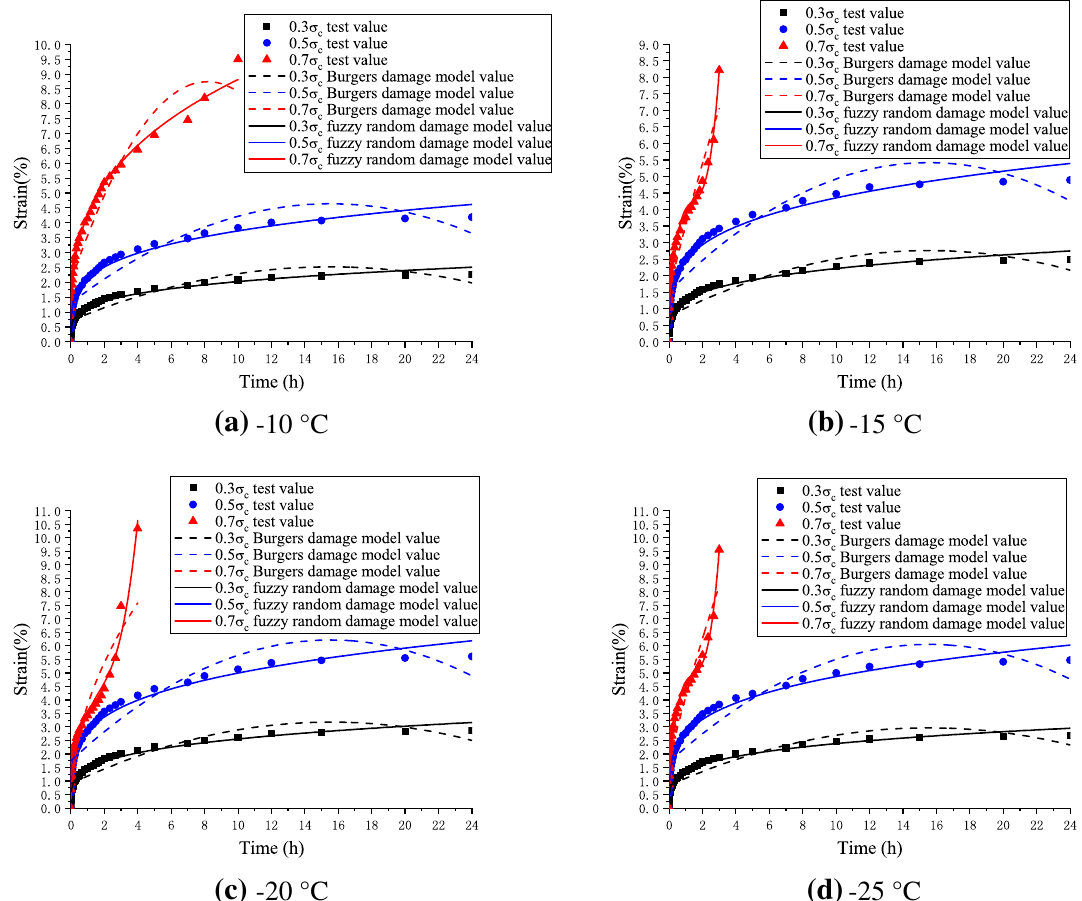
Figure 4. Comparison of original Burgers damage creep values, fuzzy random damage model values with experimental